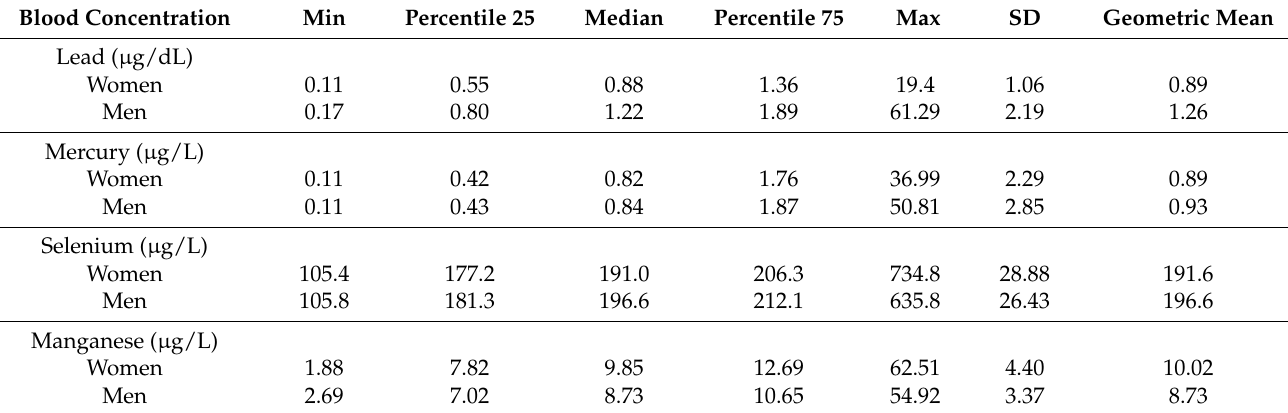
Table 2. Descriptive statistics for element concentrations in blood for women ( n = 3091) and men ( n = 3108). Blood